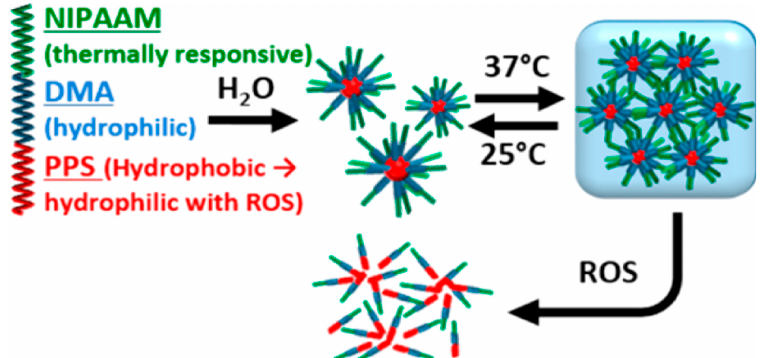
Figure 8. Concept behind hydrogels of poly[(propylenesulfide) (PPS)-( N , N -dimethylacrylamide) (DMA)-( N -isopropylacrylamide) (PNIPAAM) that undergo reversible gelation at 37 °C and degrade upon exposure to ROS. (Reprinted with permission from reference [26]. Copyright 2014 American Chemical Society).